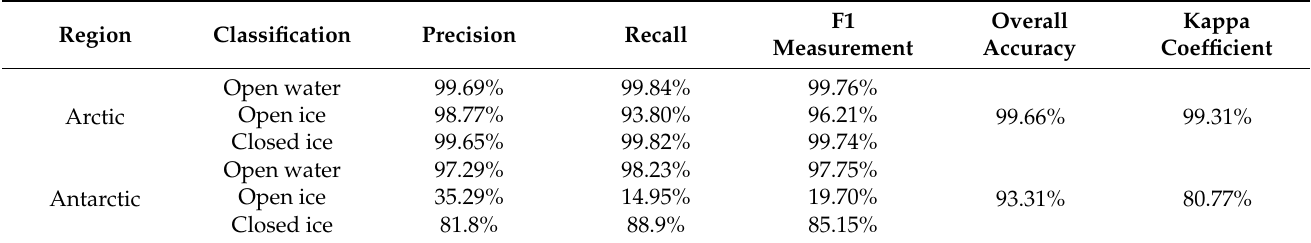
Table 6. Summary of averaged classification accuracies obtained through a random forest classifier in the Arctic and Antarctic from 1 January 2019 through 10 May 2021.